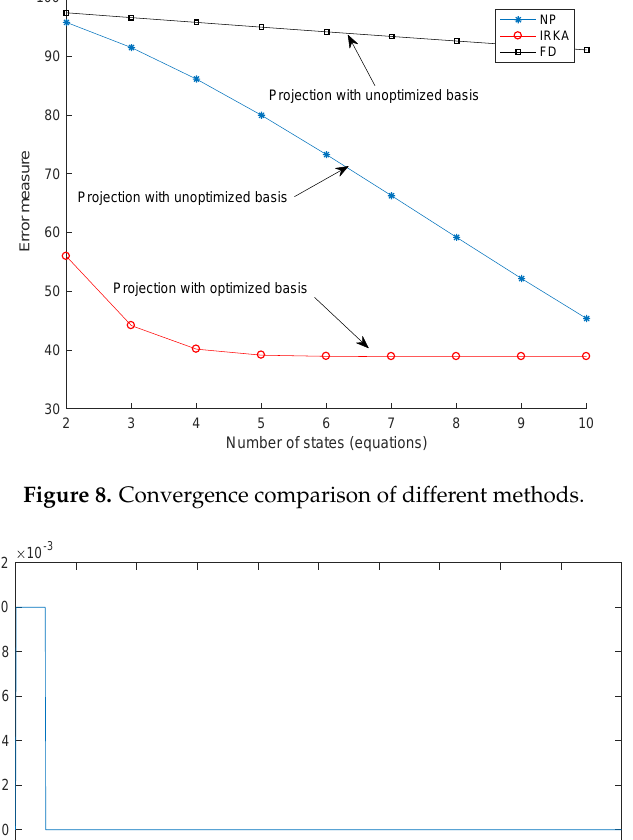
Figure 8. Convergence comparison of different methods.